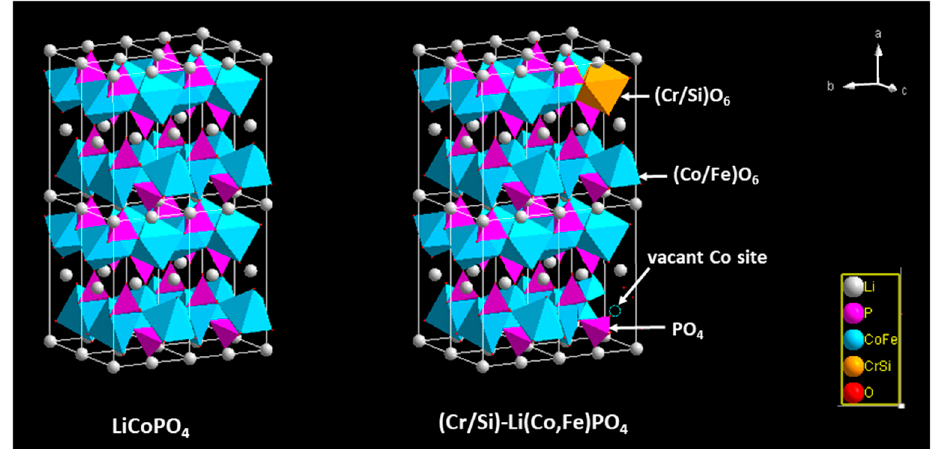
Figure 6. Schematic crystal structure diagrams of LiCoPO 4 and (Cr / Si)-Li(Co,Fe)PO 4 .